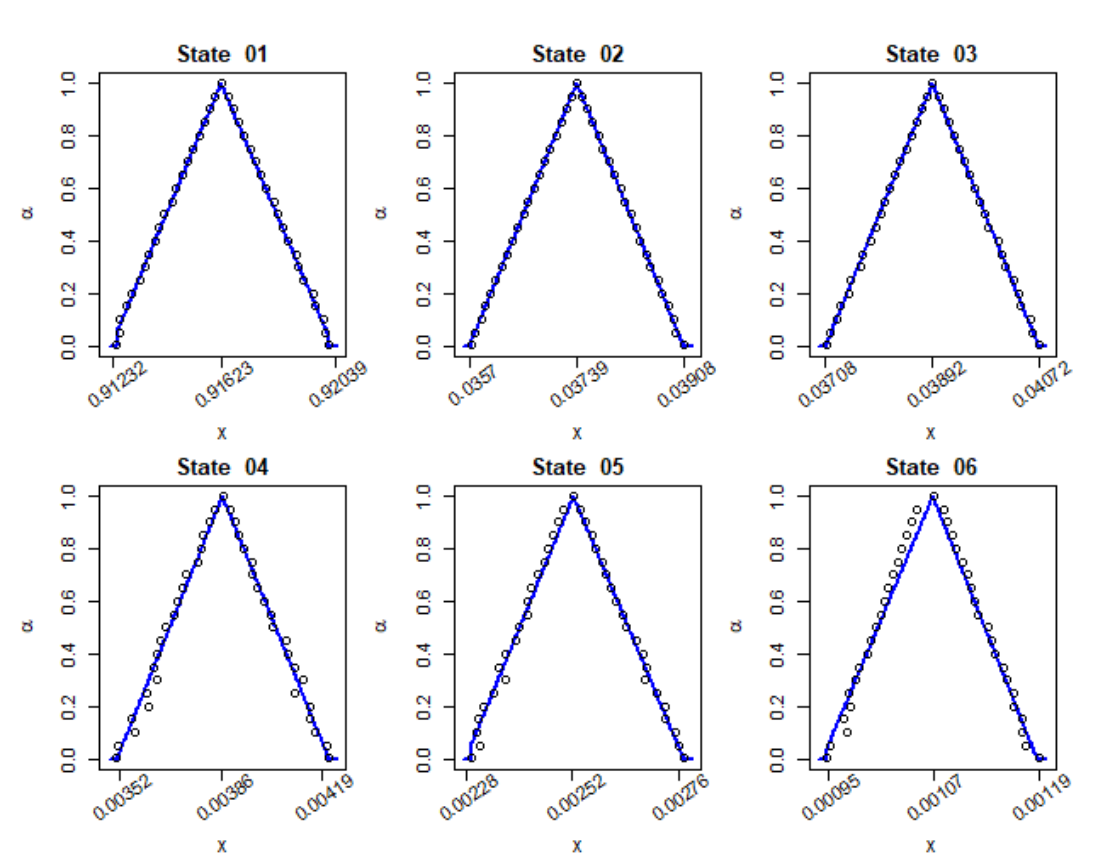
Figure 3. Results of the Irish BMS when 𝜆(cid:4634) = (0.038/0.04/0.042) —graphical representation. Source: Own elaboration